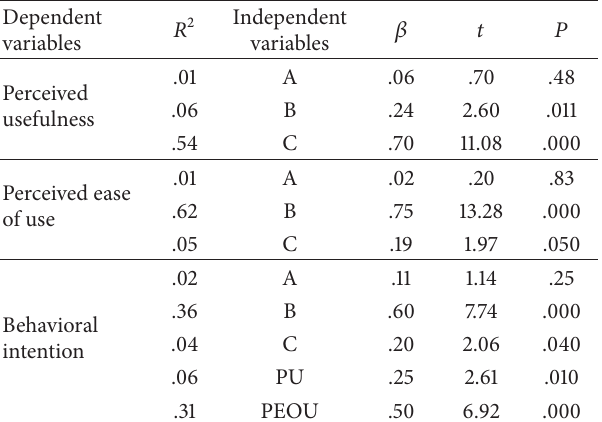
Table 9: Regression analysis of designers’ data.